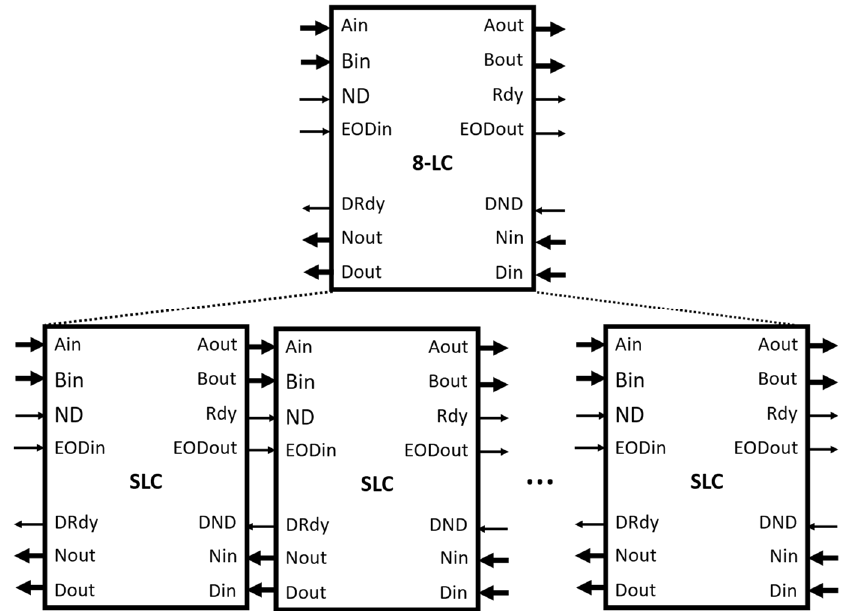
Figure 3. Creation of an 8-LC module from the SLC module. It has the same inputs and outputs as the SLC module.